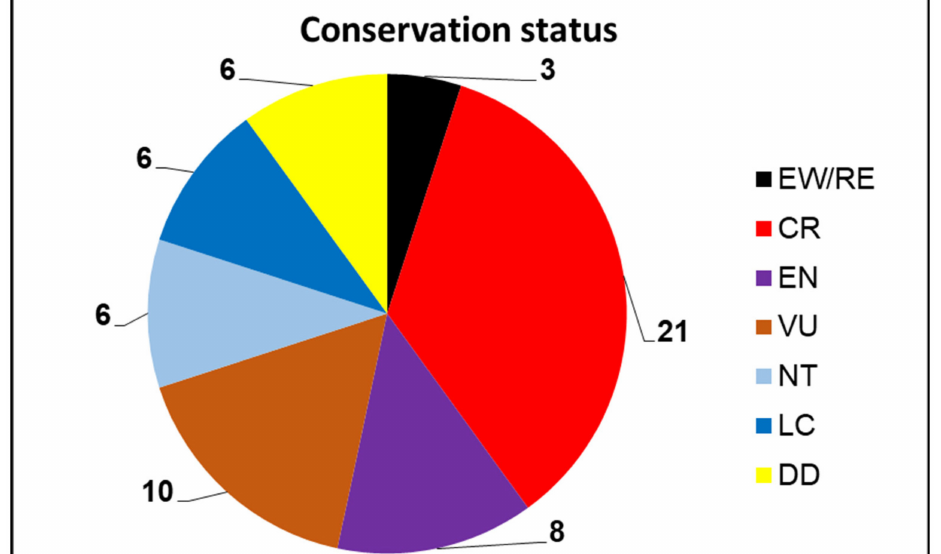
Figure 2. The division of Adriatic chondrichthyans according to their conservation status. Legend: EW = extinct in the wild, RE = regionally extinct, CR = critically endangered, EN = endangered, VU = vulnerable, NT = near threatened, LC = least concern and DD = data